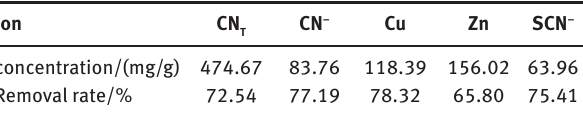
Table 8: Removal rate of each ion in cyanide wastewater with voltage of